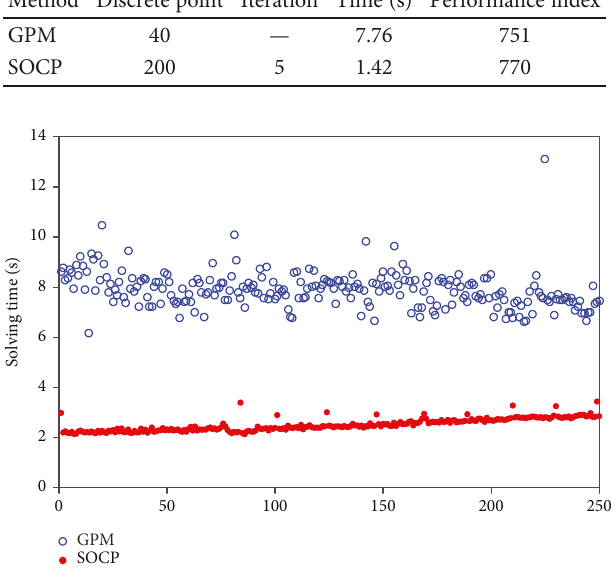
Figure 8: Calculating time for di ff erent initial guesses. Table 4: Miss distances in the two scenarios of the terminal maximum overload maneuver or no maneuver.